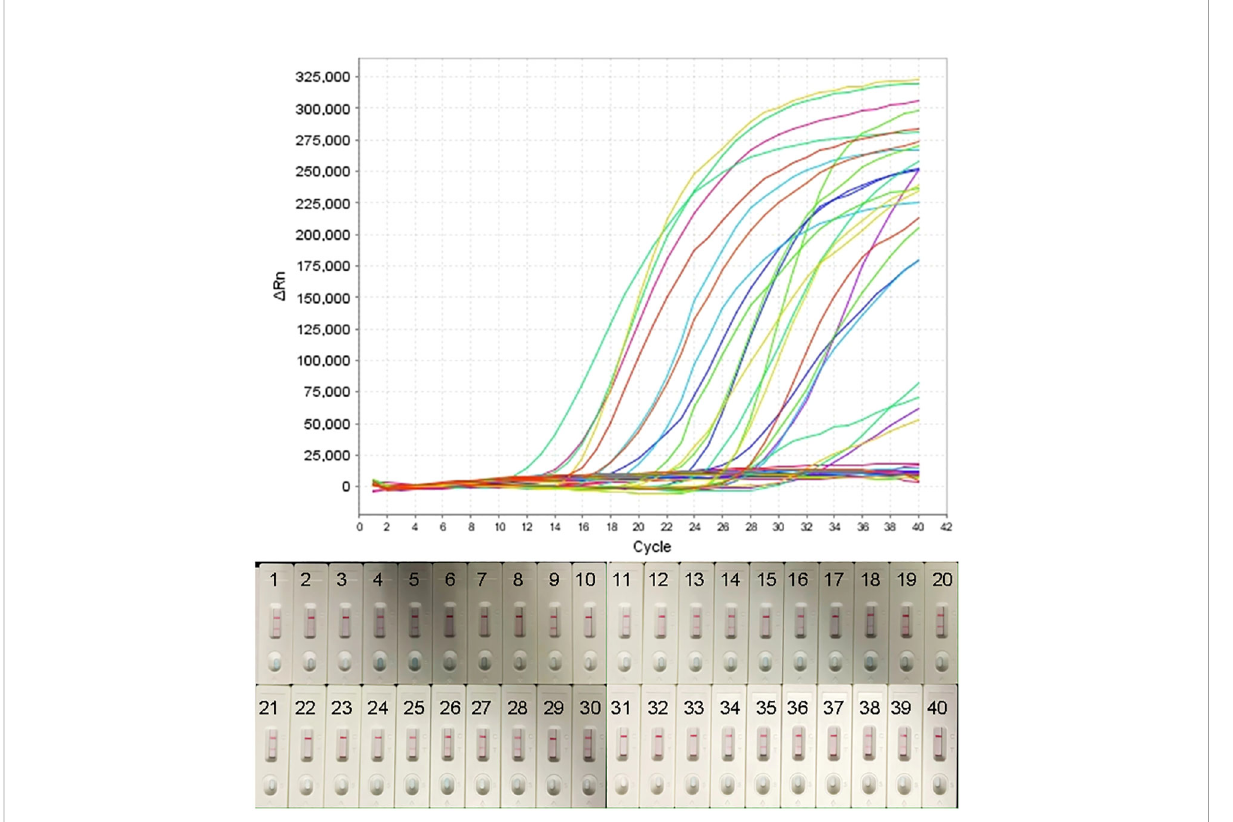
FIGURE 6 Application of H. in fl uenzae-real-time MCDA assay in clinical specimens. Forty NPS samples were detected by the H. in fl uenzae-real-time MCDA assay and the results showed that 25 samples tested positive. The results were con fi rmed by the MCDA-LFB test